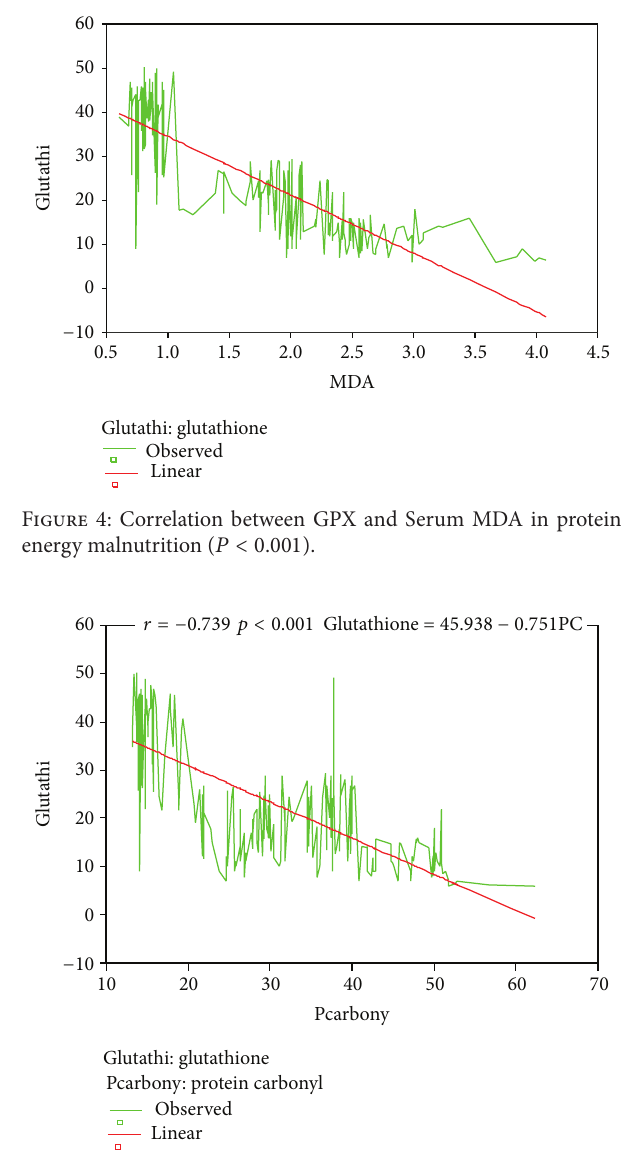
Figure 5: Correlation between GPX and Serum Protein Carbonyl in protein energy malnutrition ( 𝑃 < 0.001